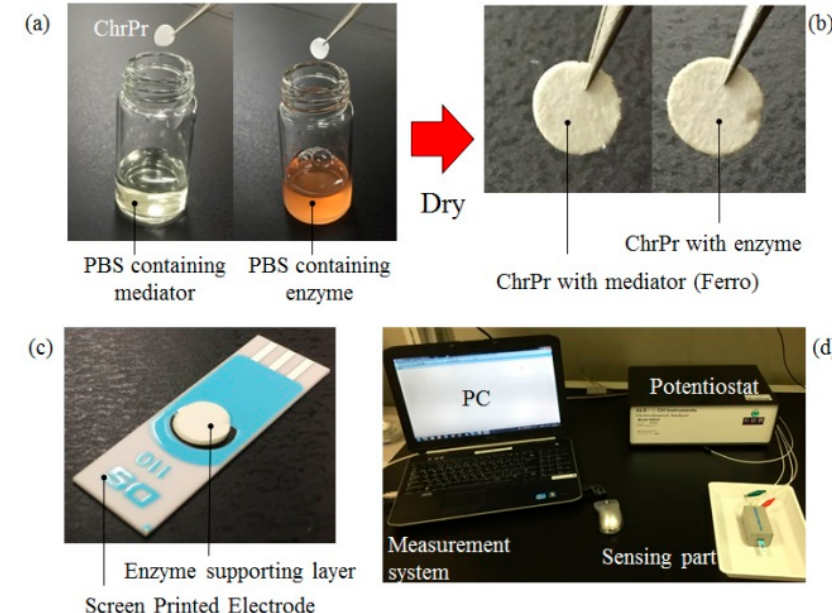
Figure 2. Enzyme supporting layer is a lamination of enzyme layer and mediator layer. ( a ) ChrPrs dipped into the solutions containing AOD and HRP or Ferro; ( b ) ChrPrs left to dry in a refrigerator at 4 ◦ C for 12 h, respectively; ( c ) Modified ChrPr enzyme electrodes (ChrSPCEs) placed onto the screen-printed electrodes; ( d ) Measurement setup of ethanol gaseous analysis by the ChrSPCEs.